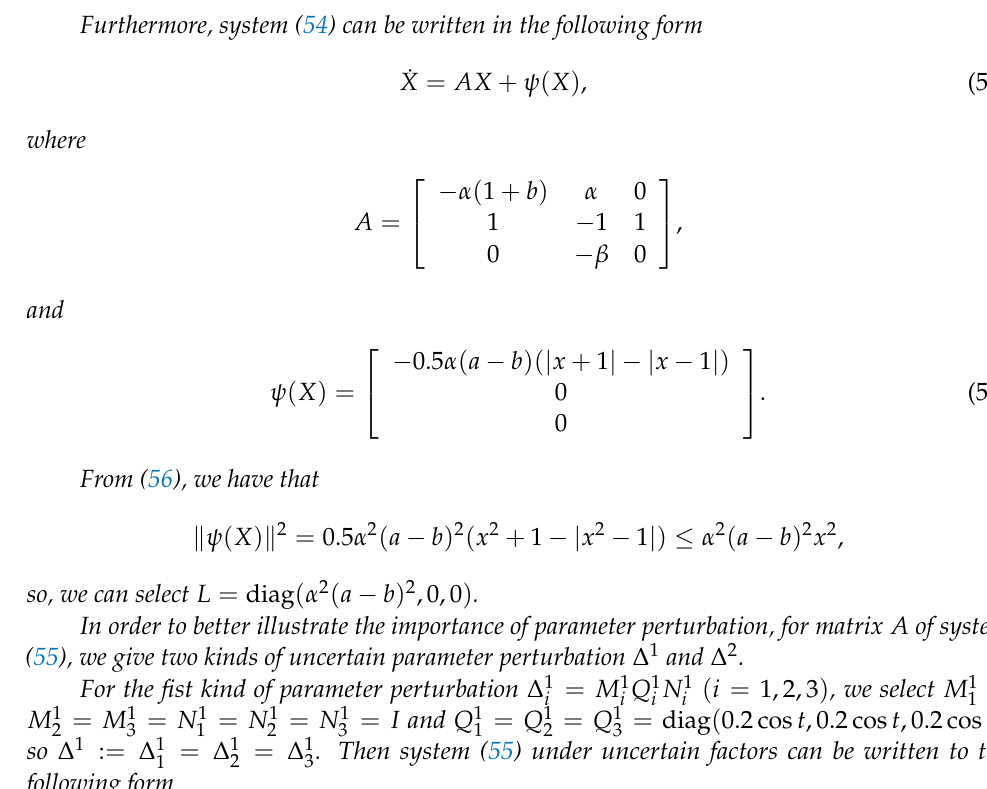
Figure 1. The chaotic phenomenon of system (54) with the initial condition X ( 0 ) = [ 4,0, − 3 ] T